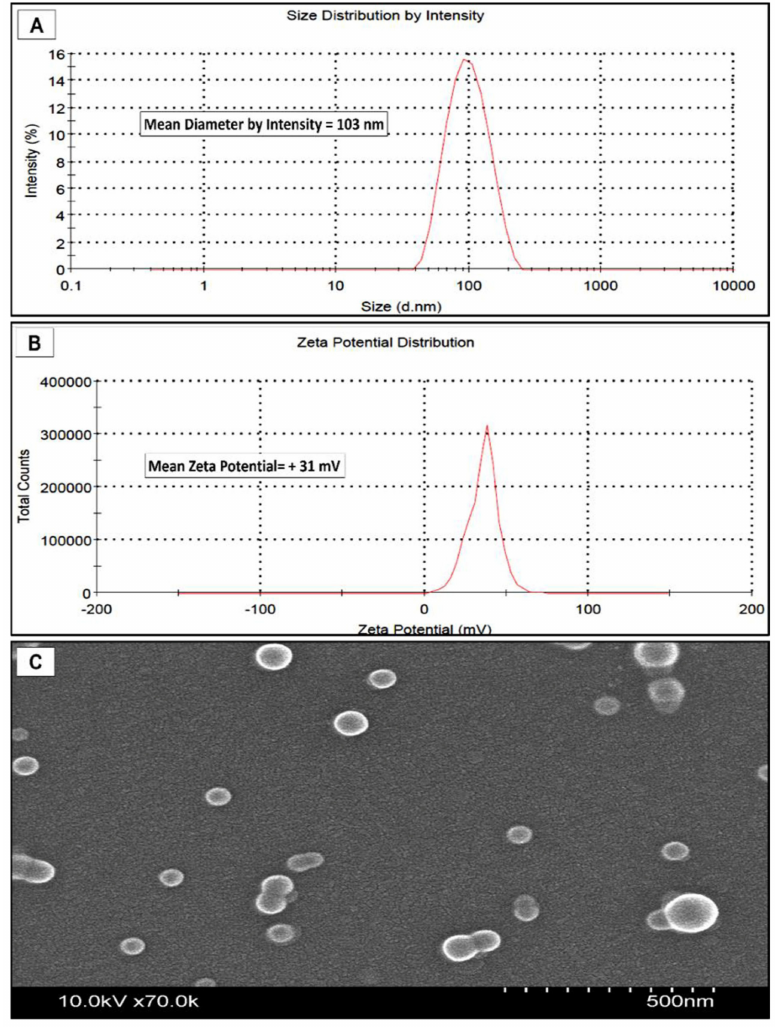
Figure 1. Characteristics of positively charged PAMAM-PLGA nanoparticles. ( A ) DLS measurements of nanoparticle diameter by scattering intensity showing unimodal distribution. ( B ) Zeta-potential (surface charge) shows a slightly positive surface charge. ( C ) SEM image shows spherical